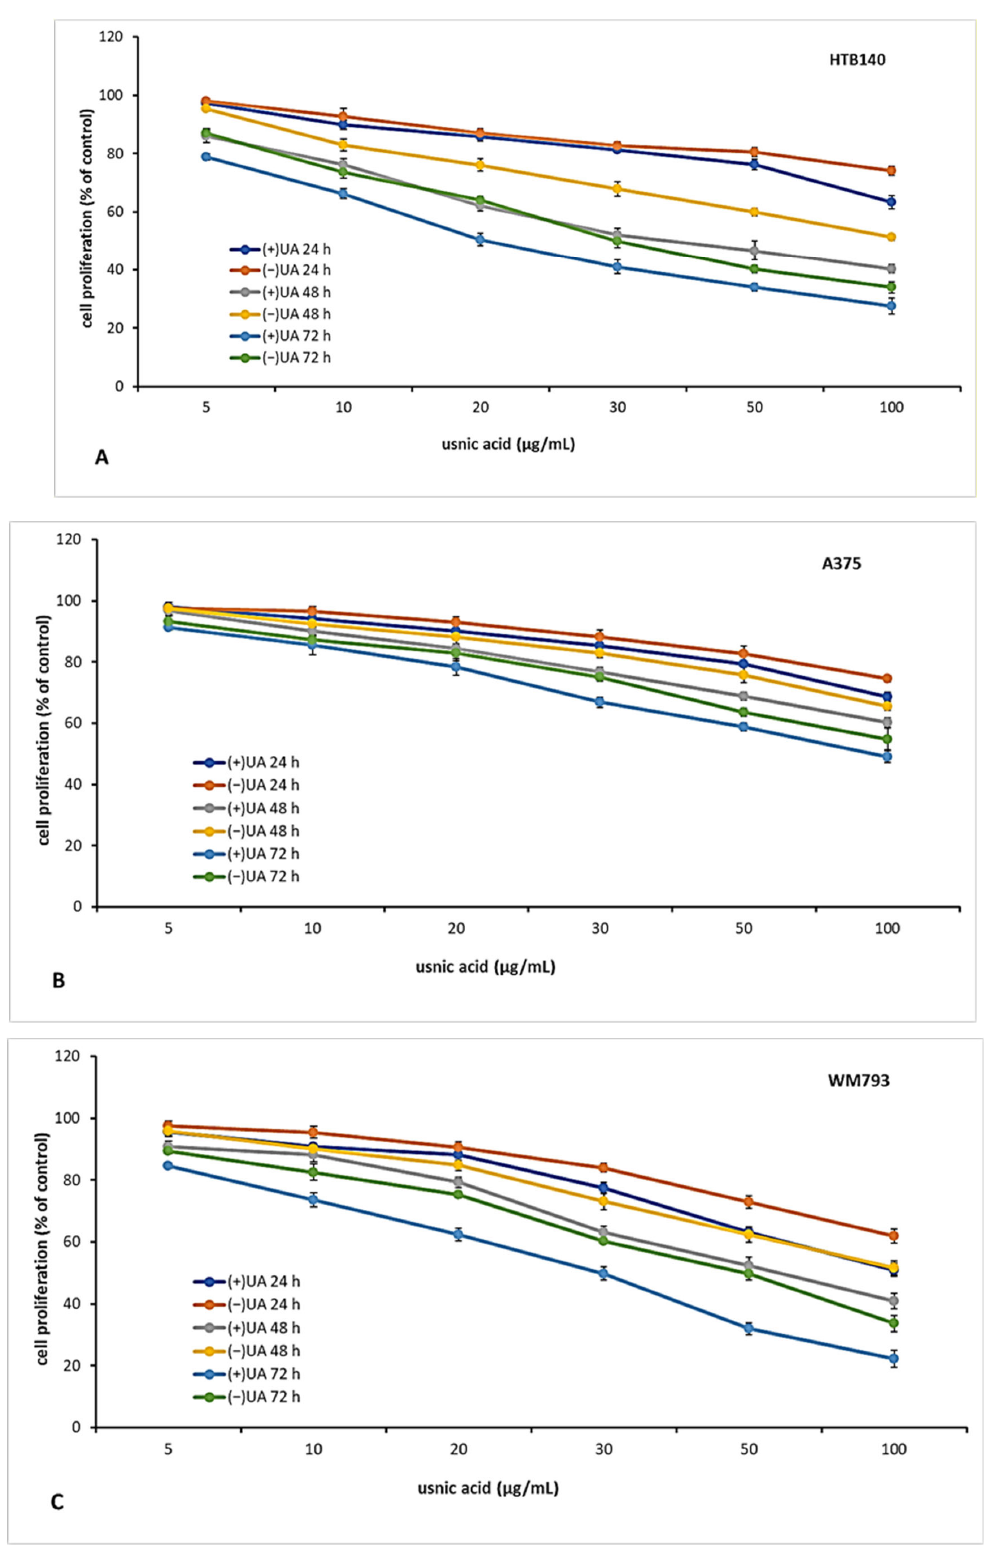
Figure 2. The effect of (+) ‐ and ( − ) ‐ usnic acid on proliferation of HTB140 ( A ), A375 ( B ) and WM793 ( C ) human melanoma